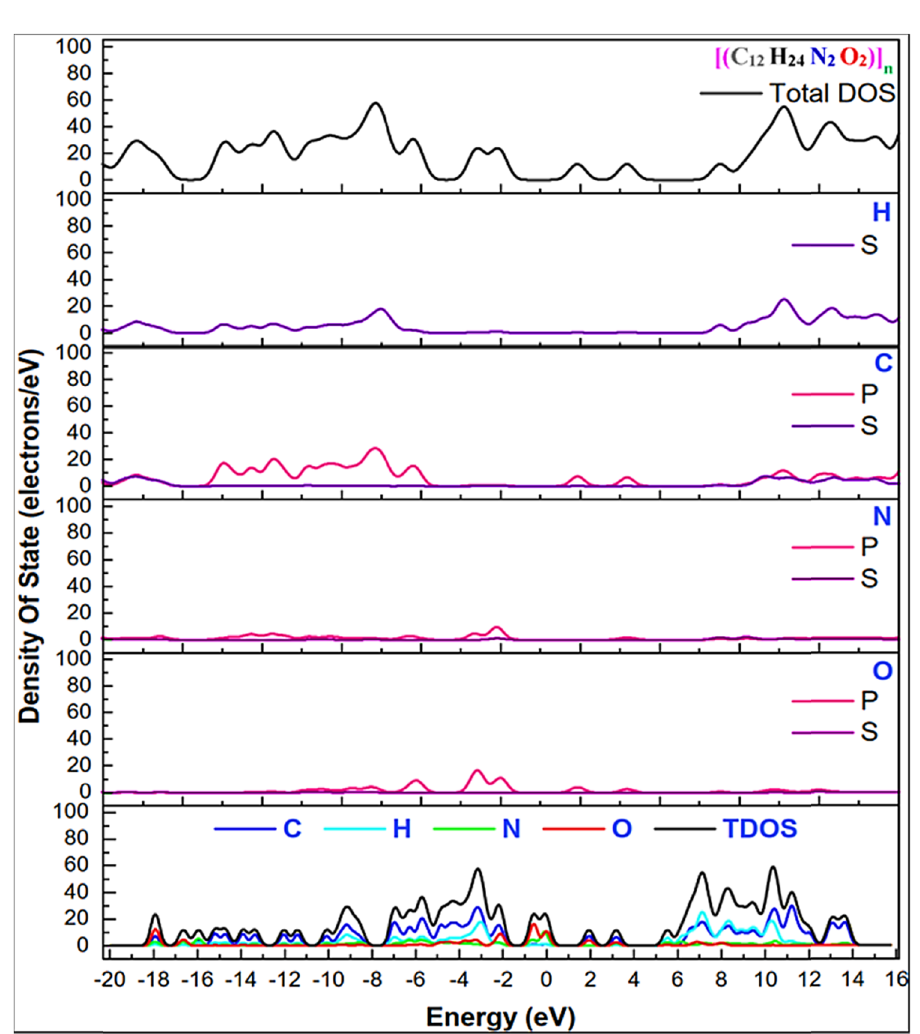
Figure 9: Total and local density of states for nylon 66 in Brillouin zone using GGA - PBE.